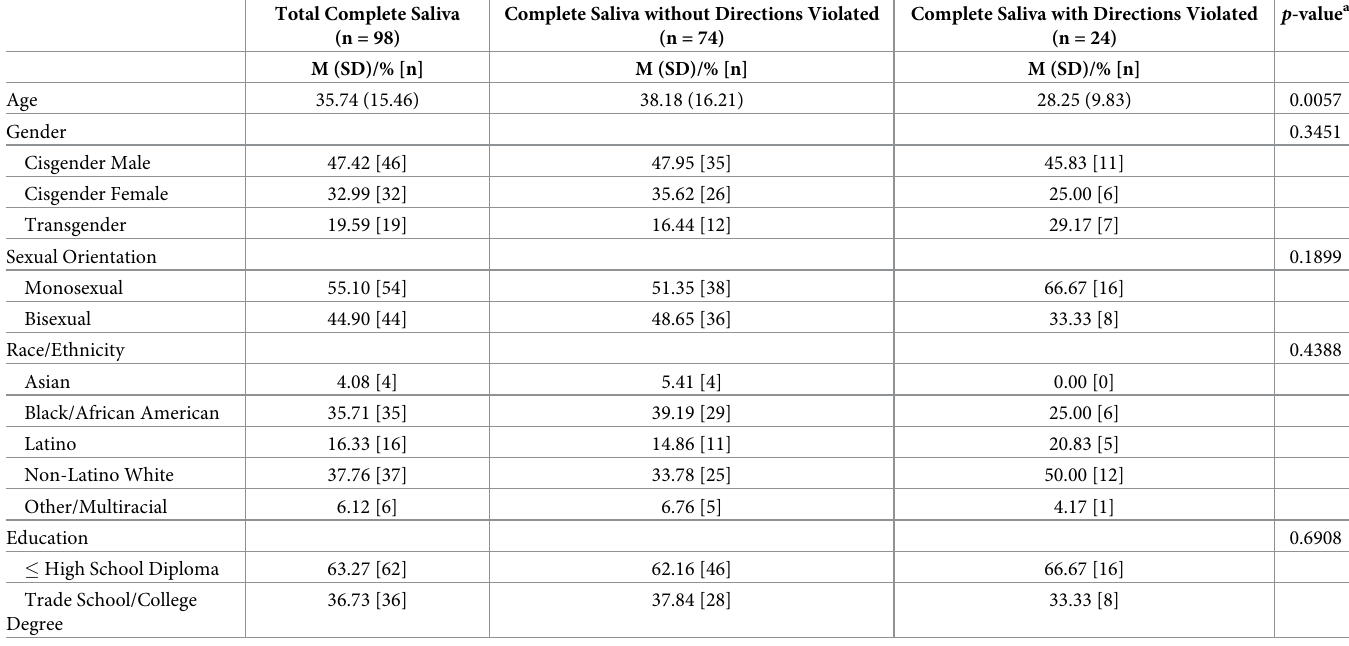
Table 3. Characteristics of participants by providing entire 6 saliva samples without directions violated versus those with directions